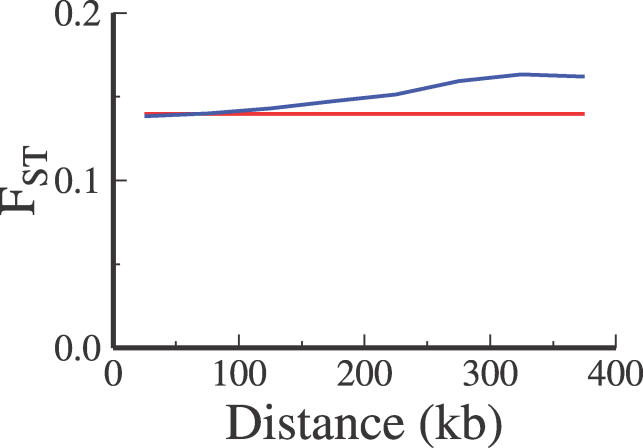
Average Fst Values for the Perfectly Correlated SNPs and All SNPsRed line shows the average values for all frequency matched SNPs according to the distance separating the SNPs in 50-kb bins; Fst values for each SNP are included only once per bin. Blue lines show the corresponding average Fst values for just the perfectly correlated SNPs.